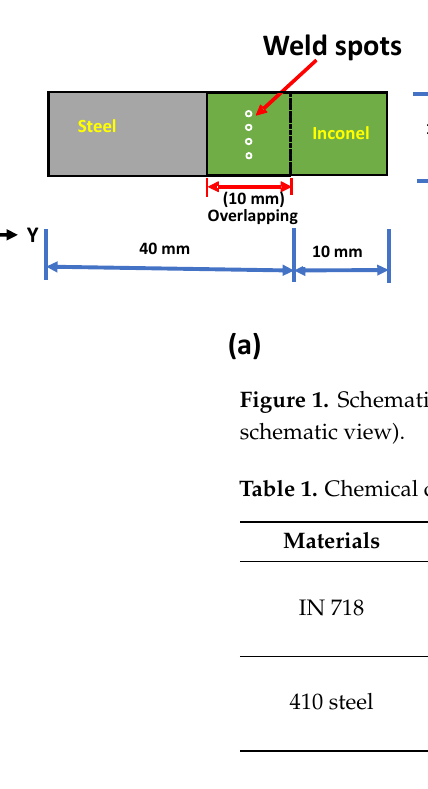
Table 2. Process parameters and their